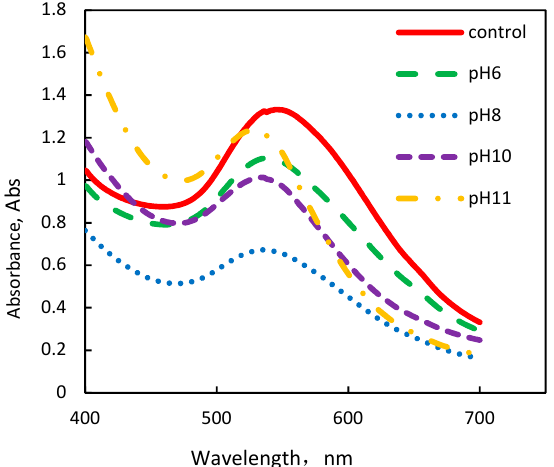
Figure 1. UV-vis spectra of AuNPs solutions obtained from Citrus sinensis (C. sinensis) peel at different pHs adjusted before the reaction: (a) control; (b) pH = 6; (c) pH = 8; (d) pH = 10; (e) pH = 11.